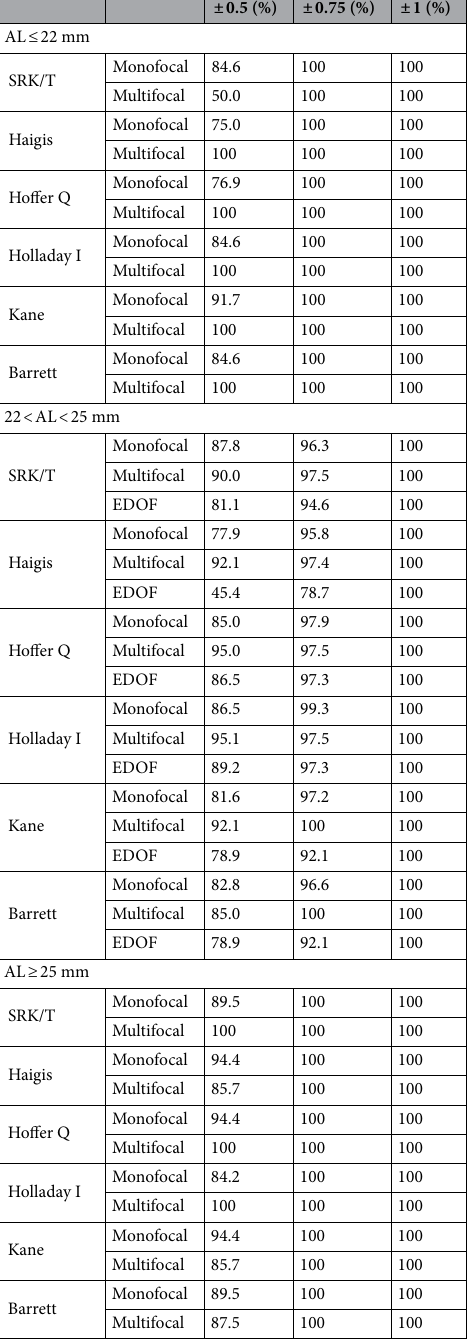
Table 4. Percentage of eyes within certain range of prediction error by biometric formula and type of intraocular